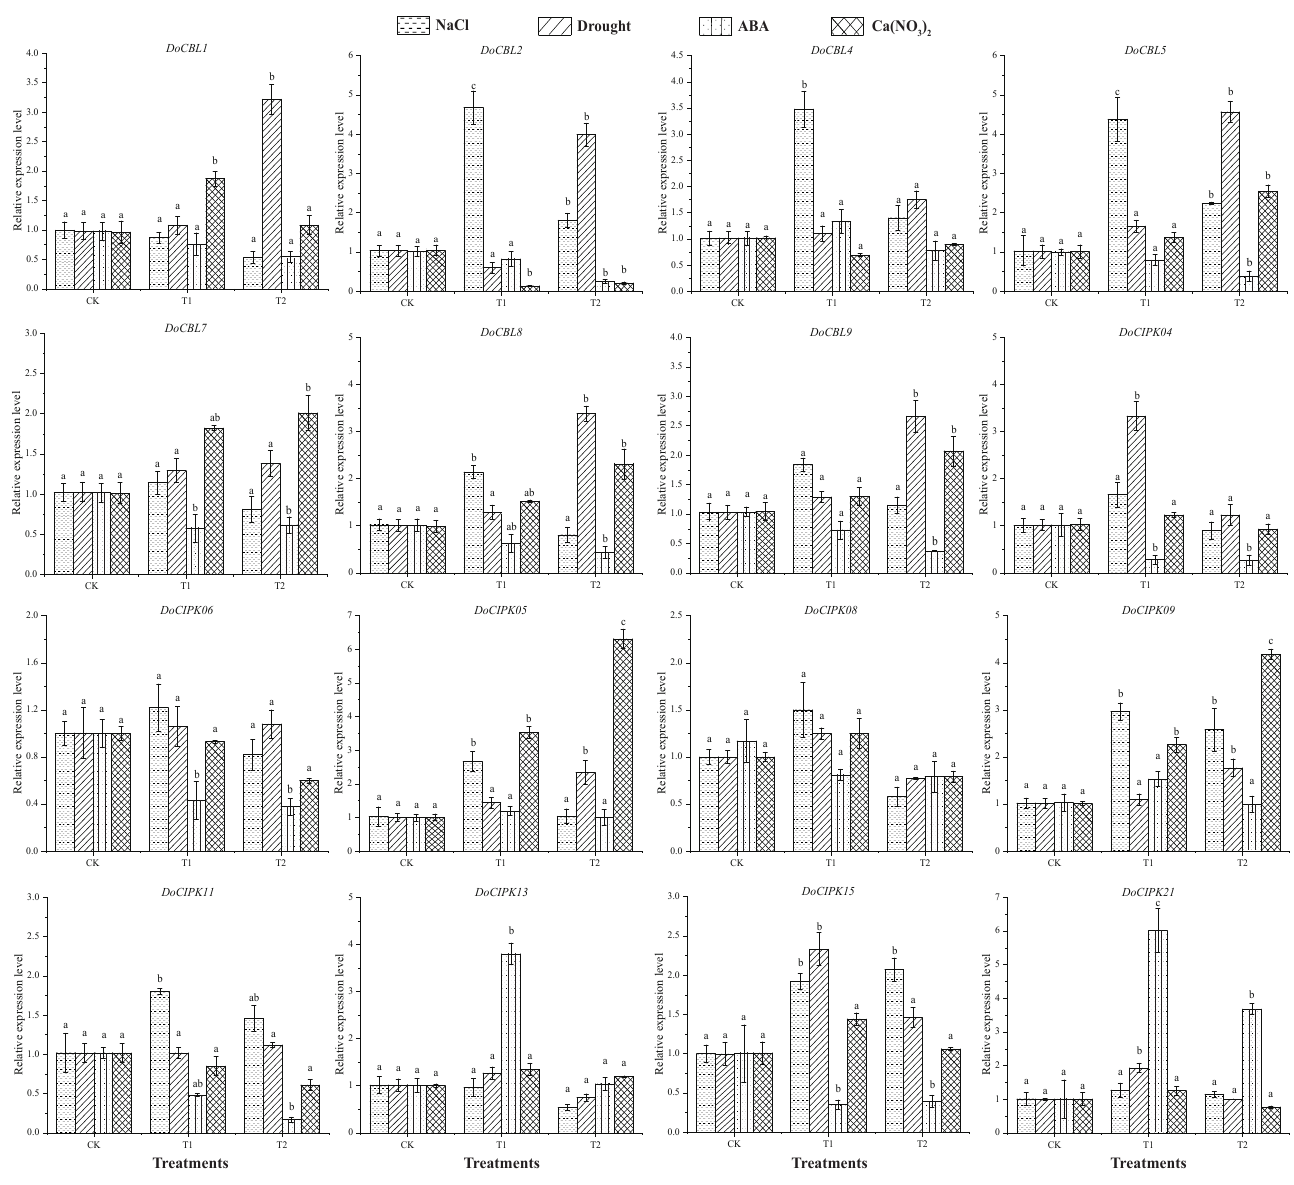
Figure 7. Expression levels of DoCBL and DoCIPK genes under NaCl, drought, ABA and Ca(NO 3 ) 2 stress. NaCl: T1 = 150 mM and T2 = 300 mM; drought: T1 = 7 d and T2 = 15 d; ABA: T1 = 50 µ M and T2 = 100 µ M; Ca(NO 3 ) 2 : T1 = 2 mM and T2 = 6 mM. Bars with different letters within each panel are significant differences at p < 0.05 among different concentrations of each stress according to Tukey’s